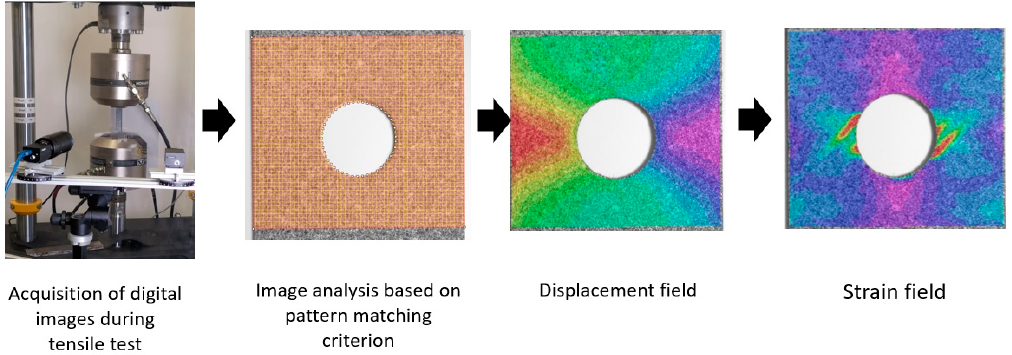
Figure 4. Scheme of digital image correlation (DIC) procedure.